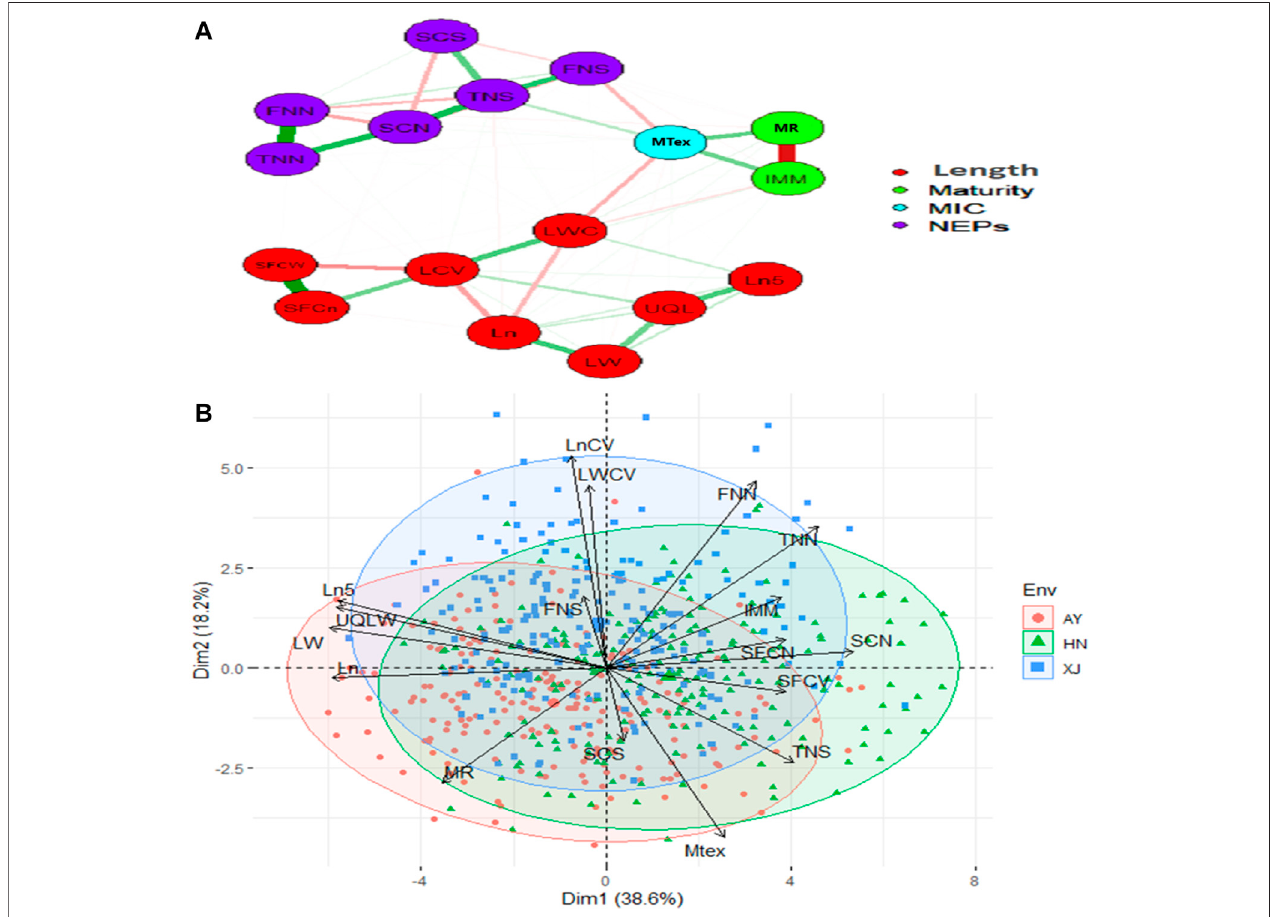
FIGURE 1 | Relationship network and PCA biplot of AFIS Relate Fiber Quality Traits (A) Relationship network between different single fi ber quality traits of G . arboreum accessions. Red and green color connection lines between each trait illustrate negative and positive relationships between them, respectively. All the investigated traits are categorized into four major groups of Length (Red), Maturity (Green), MIC (Blue), and NEPs (Purple) (B) PCA-based biplot on the phenotypic variation of single fi ber quality traits projected in the PCA1 and PCA2 planes. Legends on the top right: Three different colors represent different environments in which G. arboreum accessions were evaluated; Black to red color gradient represents the contribution of each trait in variation.